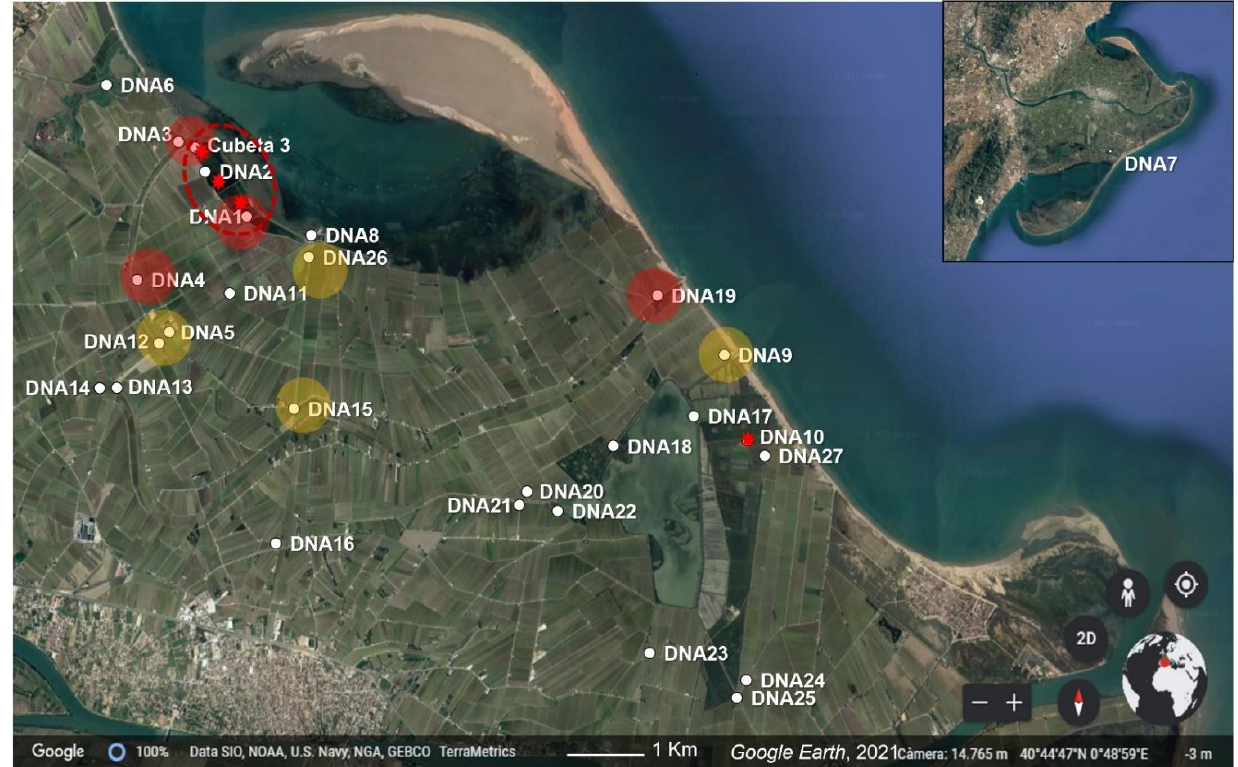
Figure 1. Map of the Ebre Delta with sampled locations. Samples where American bullfrog eDNA was confirmed by multiple primer sets are shaded in red. Samples where American bullfrog eDNA was confirmed by a single primer set are shaded in orange. Red symbol indicates the place where adult or juvenile bullfrog specimens were captured. Red circled area: ground zero.